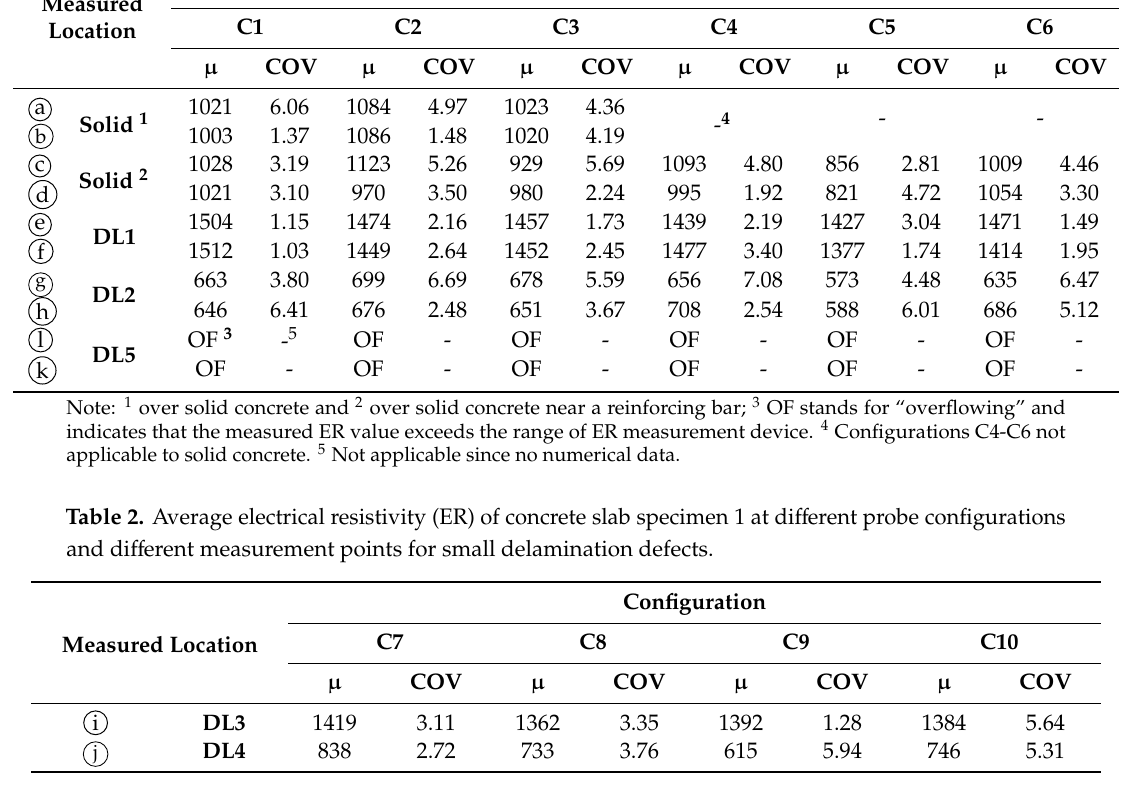
Table 3. K-S test statistic (D) to check the normal distribution of the electrical resistivity measurement for large delamination of the concrete slab specimen 1.